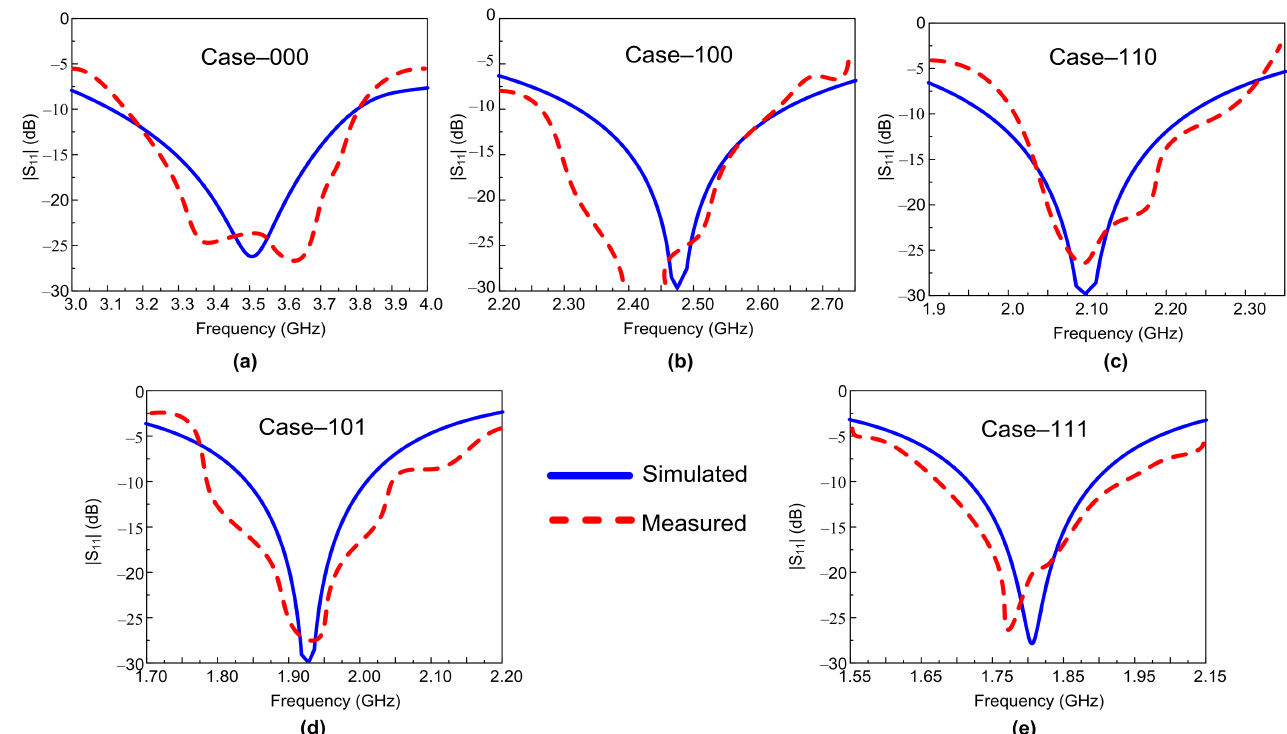
Figure 9. Simulated and measured |S 11 | proposed antenna for various switch states. ( a ) Case-000;